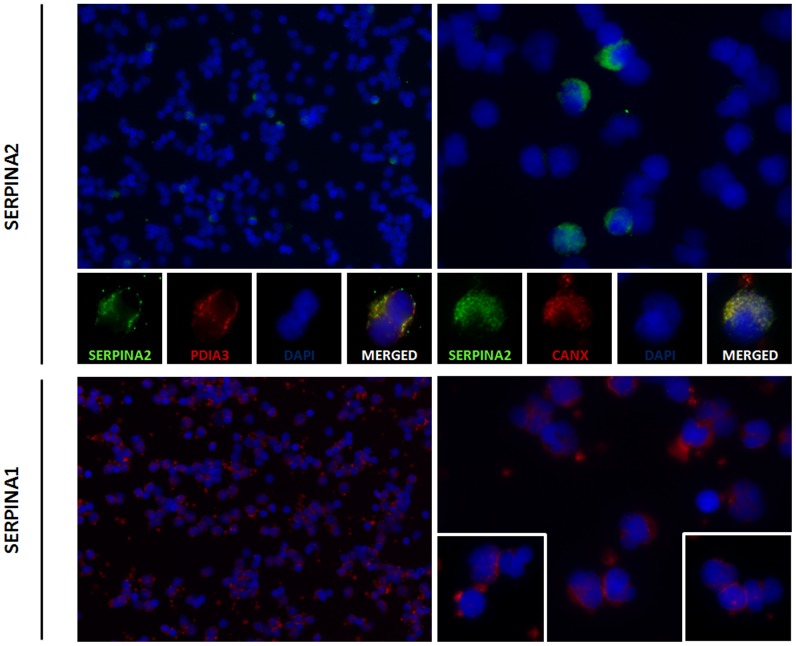

In vivo expression of SERPINA2 and SERPINA1.Leukocytes were collected from blood of an individual with a V2Null genotype for SERPINA2 and a M1M2 genotype for SERPINA1. SERPINA2 was stained with K12 and Alexa Fluor 488 (green) antibodies. ER chaperones (CANX or PDIA3) were detected with anti-CANX or anti-PDIA3 and Alexa Fluor 594 (red) antibodies. SERPINA1 was stained with H203 and and Alexa Fluor 594 (red) antibodies. Nuclei were stained with DAPI. Magnification 200× (left panel) 630× (right panel and insets).